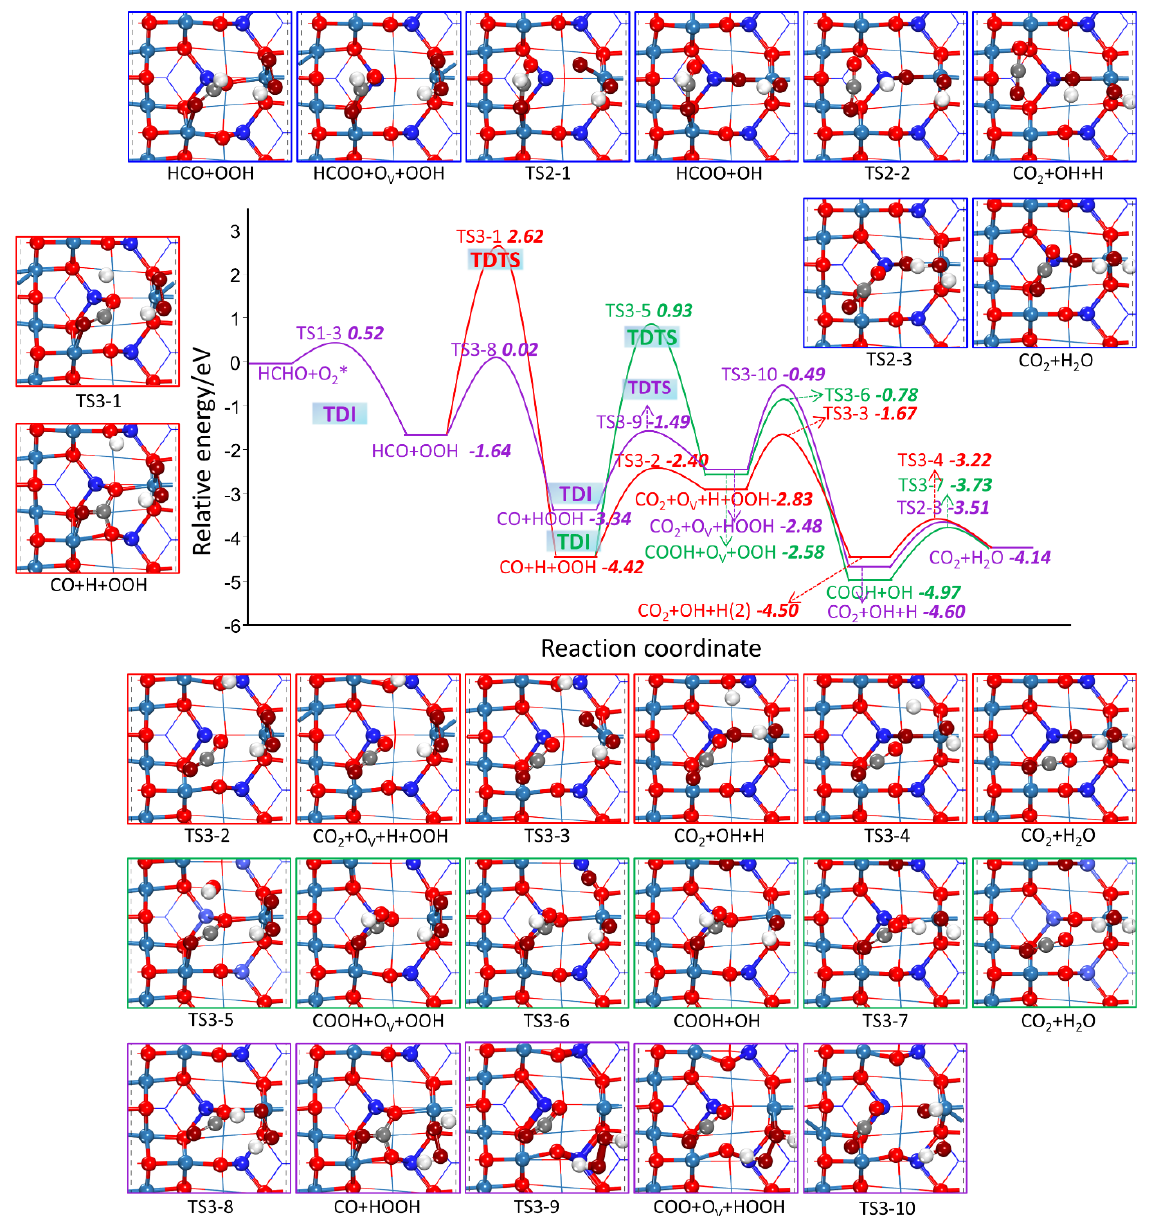
Figure 7. The potential energy profile of HCHO oxidation based on MvK mechanism through CO grabbing O latt together with the structures of TSs and FSs on Co 3 O 4 (110) surface. Starting from the reaction of CO + H + OOH (R3-2, R3-5), CO binds to O latt for CO 2 formation through TS3-2 and binds to lattice OH for COOH formation through TS3-5 with the activation barrier of 2.02 eV and 5.36 eV, respectively. The two reaction steps are endothermic with reaction energies of 1.59 and 1.84 eV, respectively, suggesting the combination of CO with lattice OH for COOH formation is blocked kinetically and thermodynamically. The following O V filling by OOH dissociation through TS3-3 and TS3-6 exhibits the activation barrier of 1.16 eV and 1.80 eV, respectively, which are different from that of R2-1, indicating that OOH dissociation is affected by co-adsorbents. As for the reaction of OH combining with H atom (TS3-4) and the reaction of H atom of COOH transferring to OH for H 2 O formation (TS3-7), their activation barriers are 1.40 eV and 1.24 eV, respectively. Starting from the reaction of CO+HOOH, CO reacts with O latt to produce CO 2 , and HOOH dissociates into two OH groups. One OH occupies O V , the